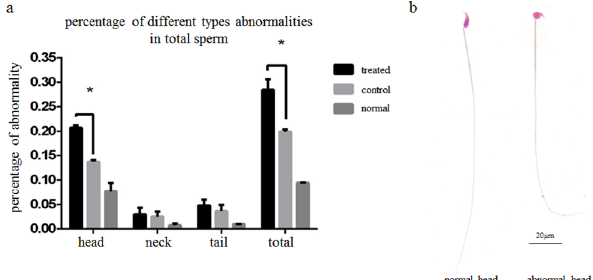
Fig 3. Ordinary optical microscopy of sperm from the caudal epididymis. Paired testes from the same 3 week-old mouse were injected with miR-124 mimic or negative control miRNA, respectively. Different types of sperm abnormality in the cauda epididymis were observed 3 weeks later by ordinary optical microscopy. (a) The ratios were subjected to arcsine square root transformation prior to Student ’ s t test (two-tailed) * p < 0.05 compared with control. Error bars indicate SD. (b) Normal and abnormal head shapes of sperm from the cauda epididymis. Bar = 20 μ